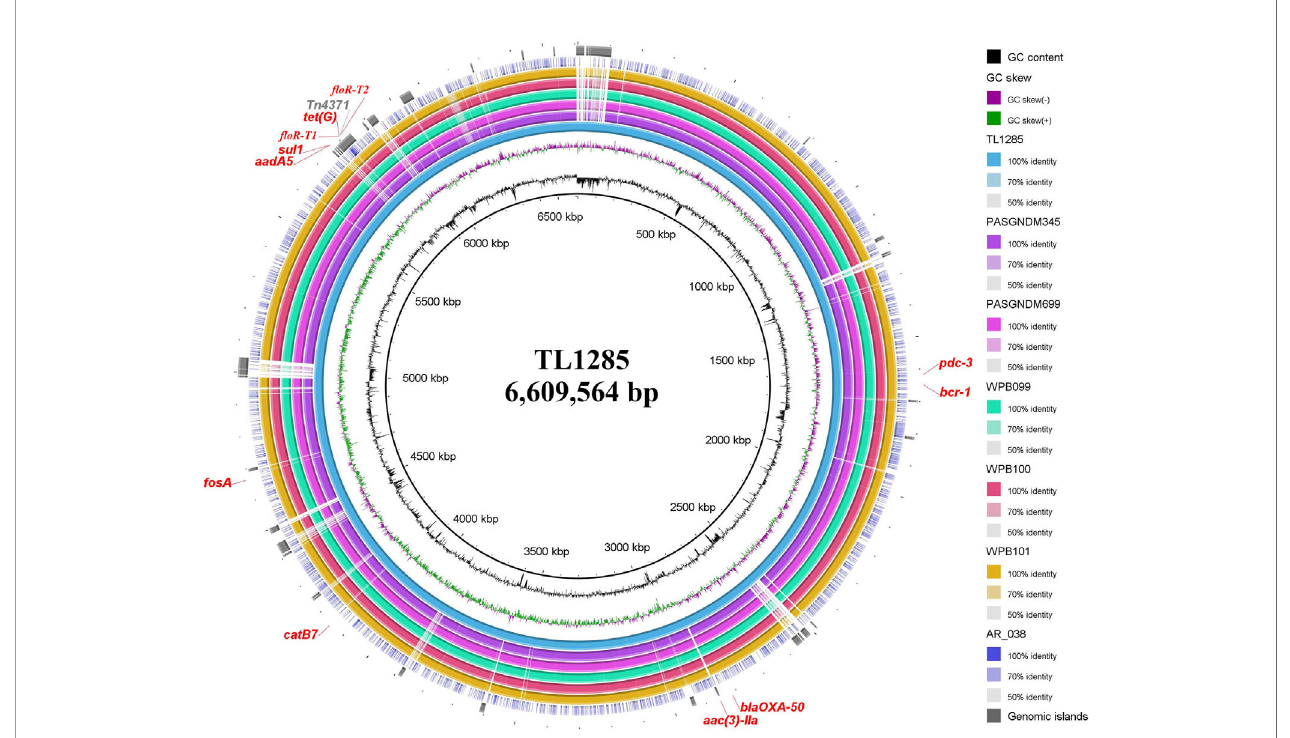
FIGURE 4 | Sequence conservation among P. aeruginosa TL1285 and 6 other genomes carrying fl oR-T2 . From innermost to outermost: Circle 1 shows the scale in kb; Circles 2 and 3 represent the GC content and GC skew maps of TL1285, respectively; Circle 4 represents the genome of TL1285; Circles 5-10 represent the